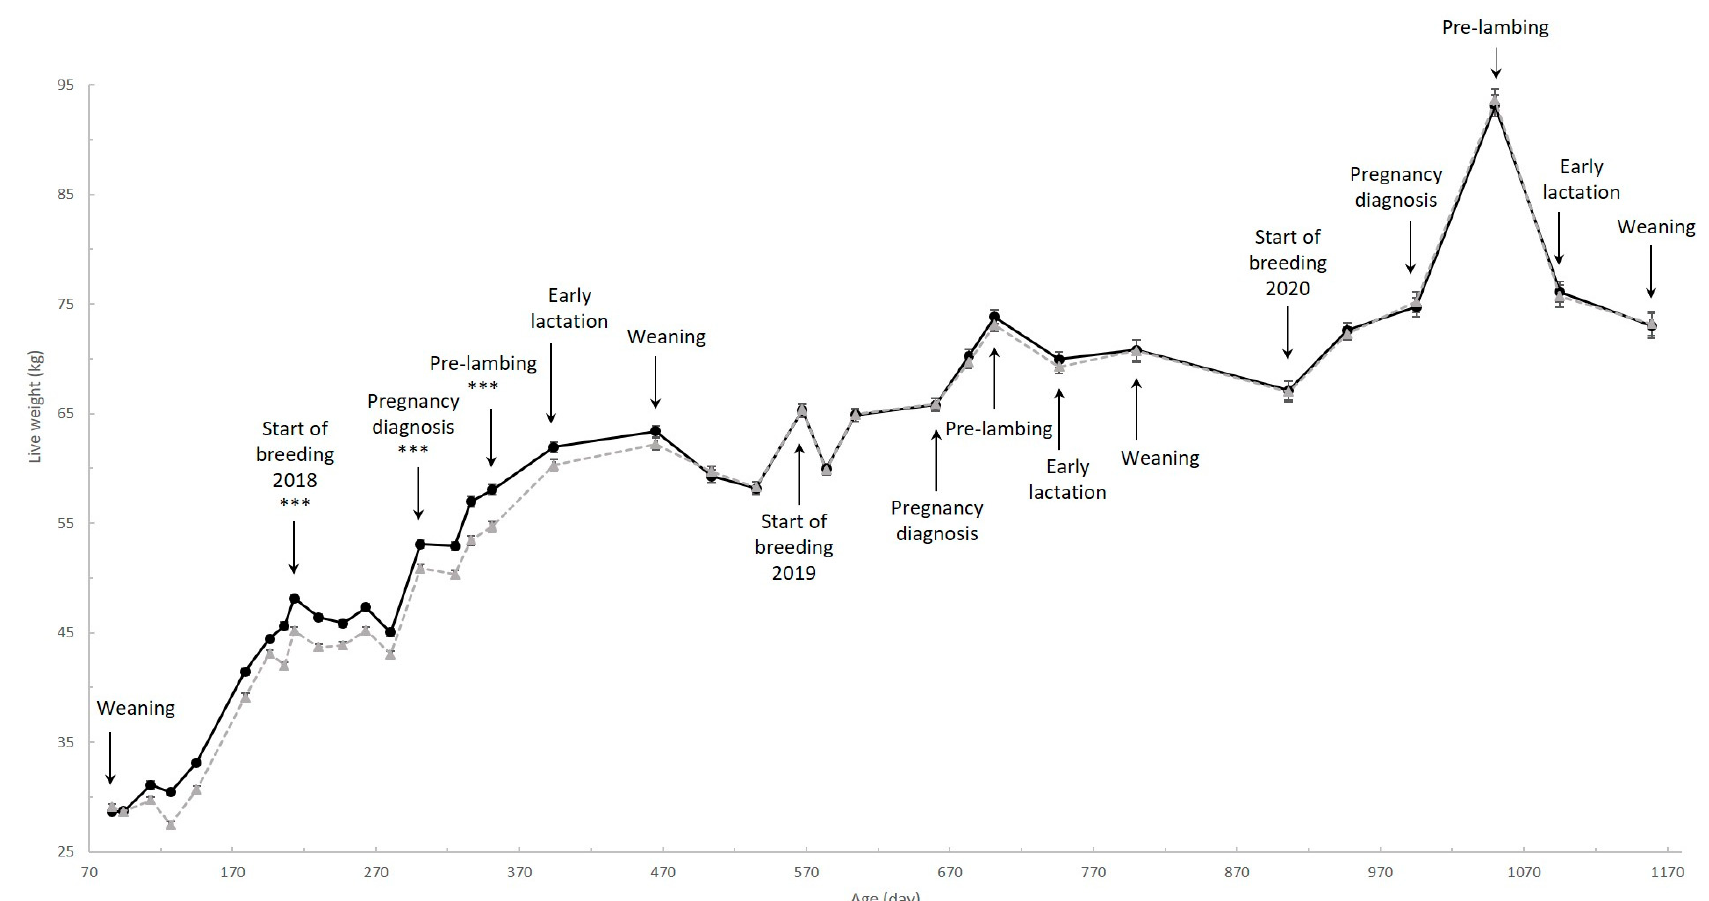
Figure 1. Live weight (± SEM) of all ewes in the heavy (black solid line) and the control (grey dotted line) groups from their weaning (d86) to the weaning of their third set of lambs at three years of age (d1159). *** indicates treatment differences at p < 0.001.